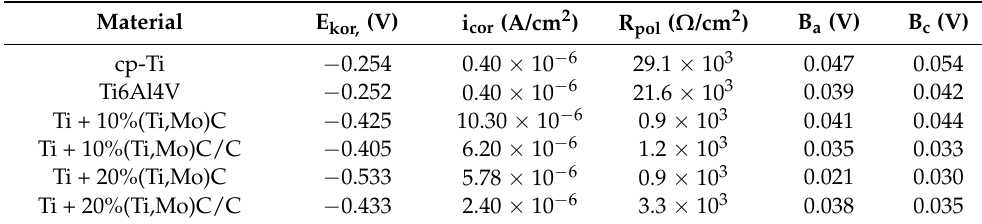
Table 4. Corrosion parameters of the composites exposed to 3.5 wt % NaCl solution RT.